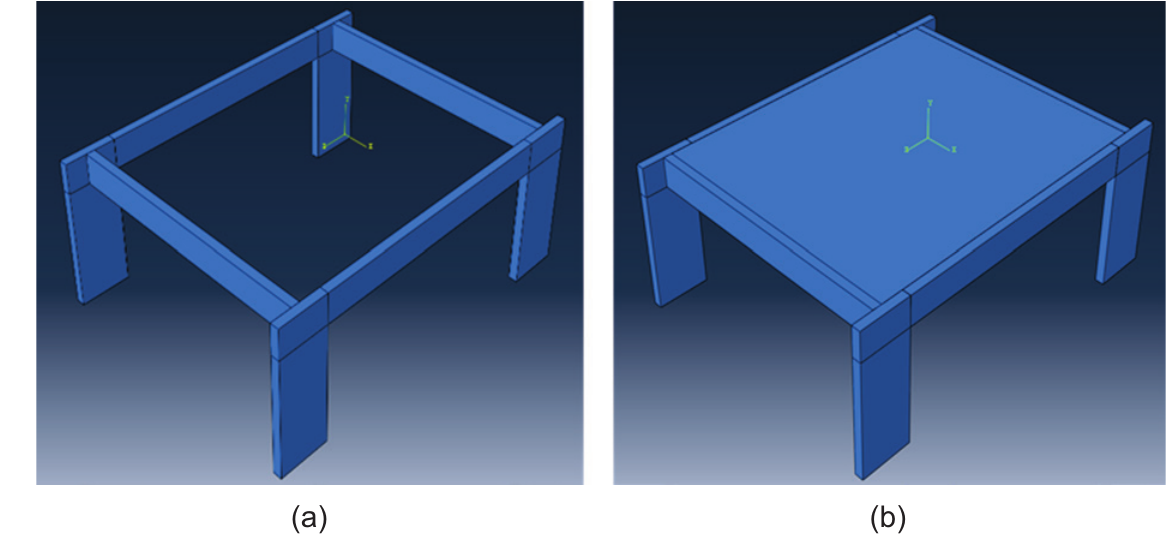
Figura 6. Na parte (a) da figura, tem-se a estrutura base para os